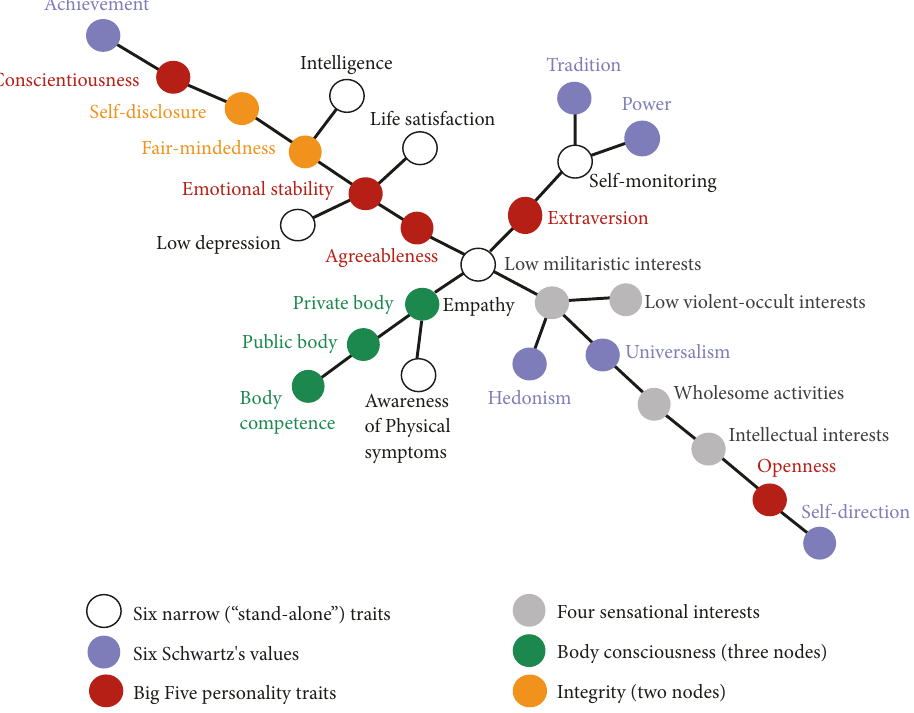
Figure 6: Minimum spanning tree (MST) based partial